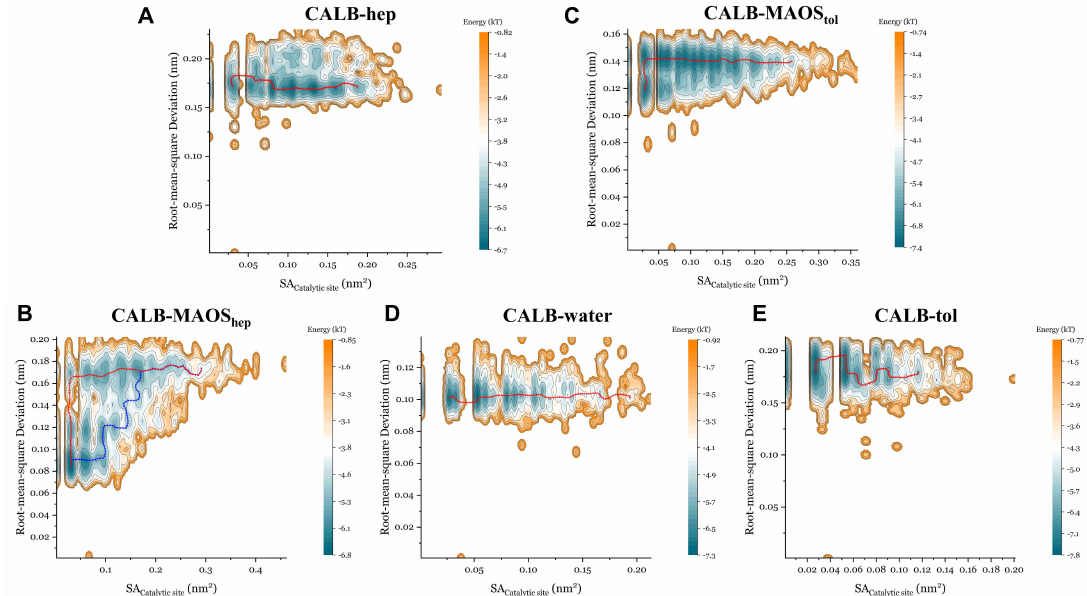
Figure 5. Energy landscape analysis of CALB with correlation to RMSD and the solvent accessible area of catalytic residues in the n-heptane systems ( A ), in the MAOS hep system ( B ), in the MAOS tol system ( C ), in water ( D ) and in the toluene system ( E ). Energy E(x) was calculated through the Boltzmann distribution. Energy landscape analysis was conducted according to the probability density P(x). Each trajectory was sampled every 100 ps in the EL analysis. The red and blue lines represent the minimum energy